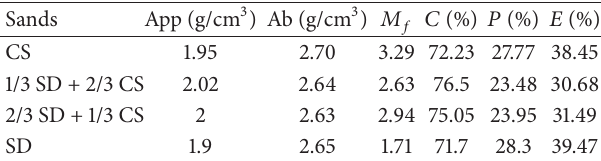
Table 3: Physical characteristics of the mixed fine aggregates (crushed and dune sand).